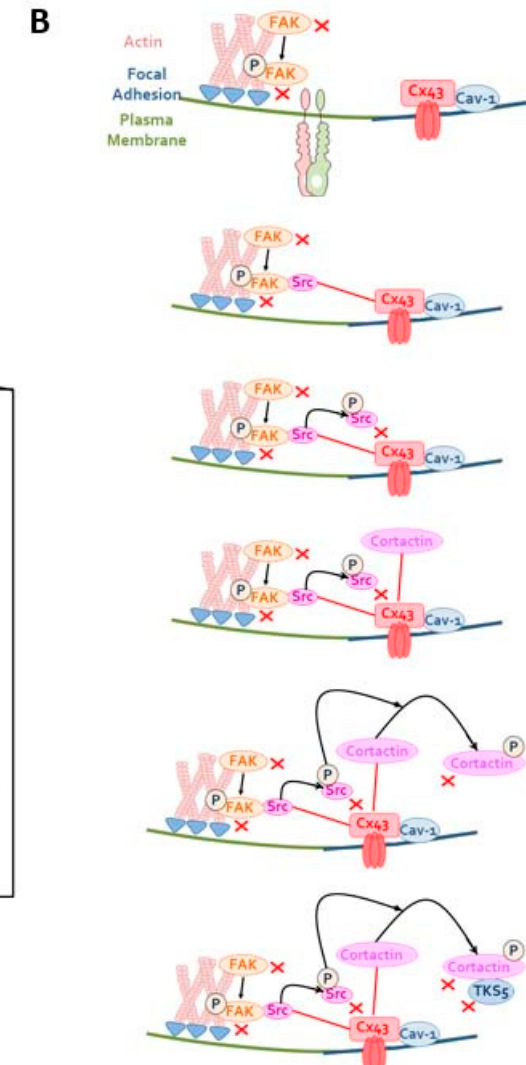
Figure 9. Possible role of Cx43 in invadopodia formation . Each stage of invadopodia formation is described in two parts: the cancer cell with localization of invadopodia structure ( A ) and a hypothetic description of protein interactions occurring during the invadopodia formation and growth ( B ). See Discussion for details.